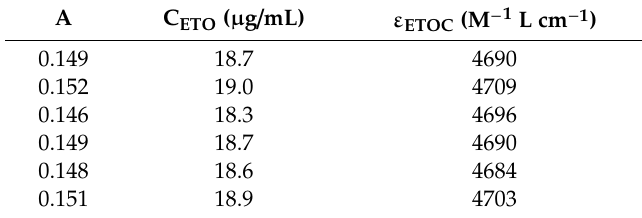
Table 1. Values of A, C ETO , and ε ETOC obtained for the six aliquots of a 50 µ g / mL sample of CPX 5 .